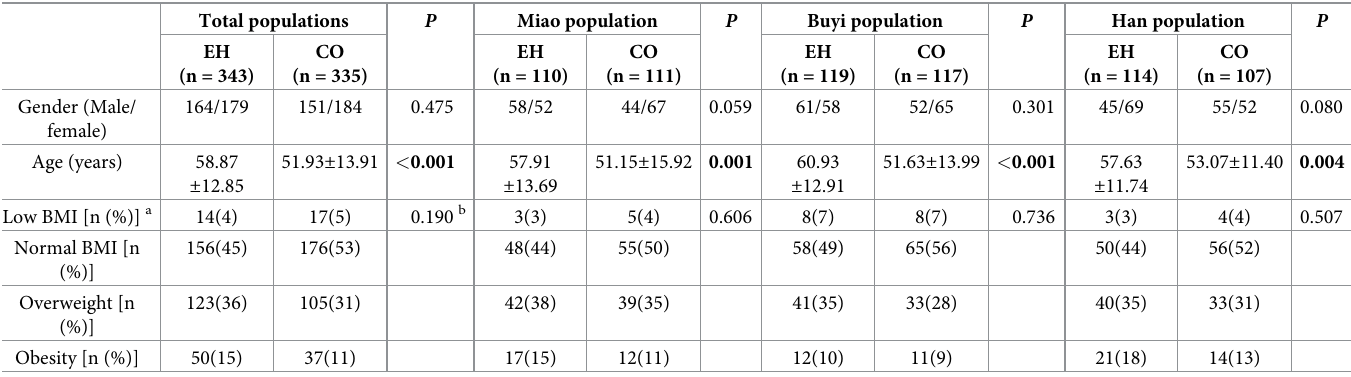
Table 1. Basic characteristics of research objects of Miao, Buyi and Han populations in Guizhou.